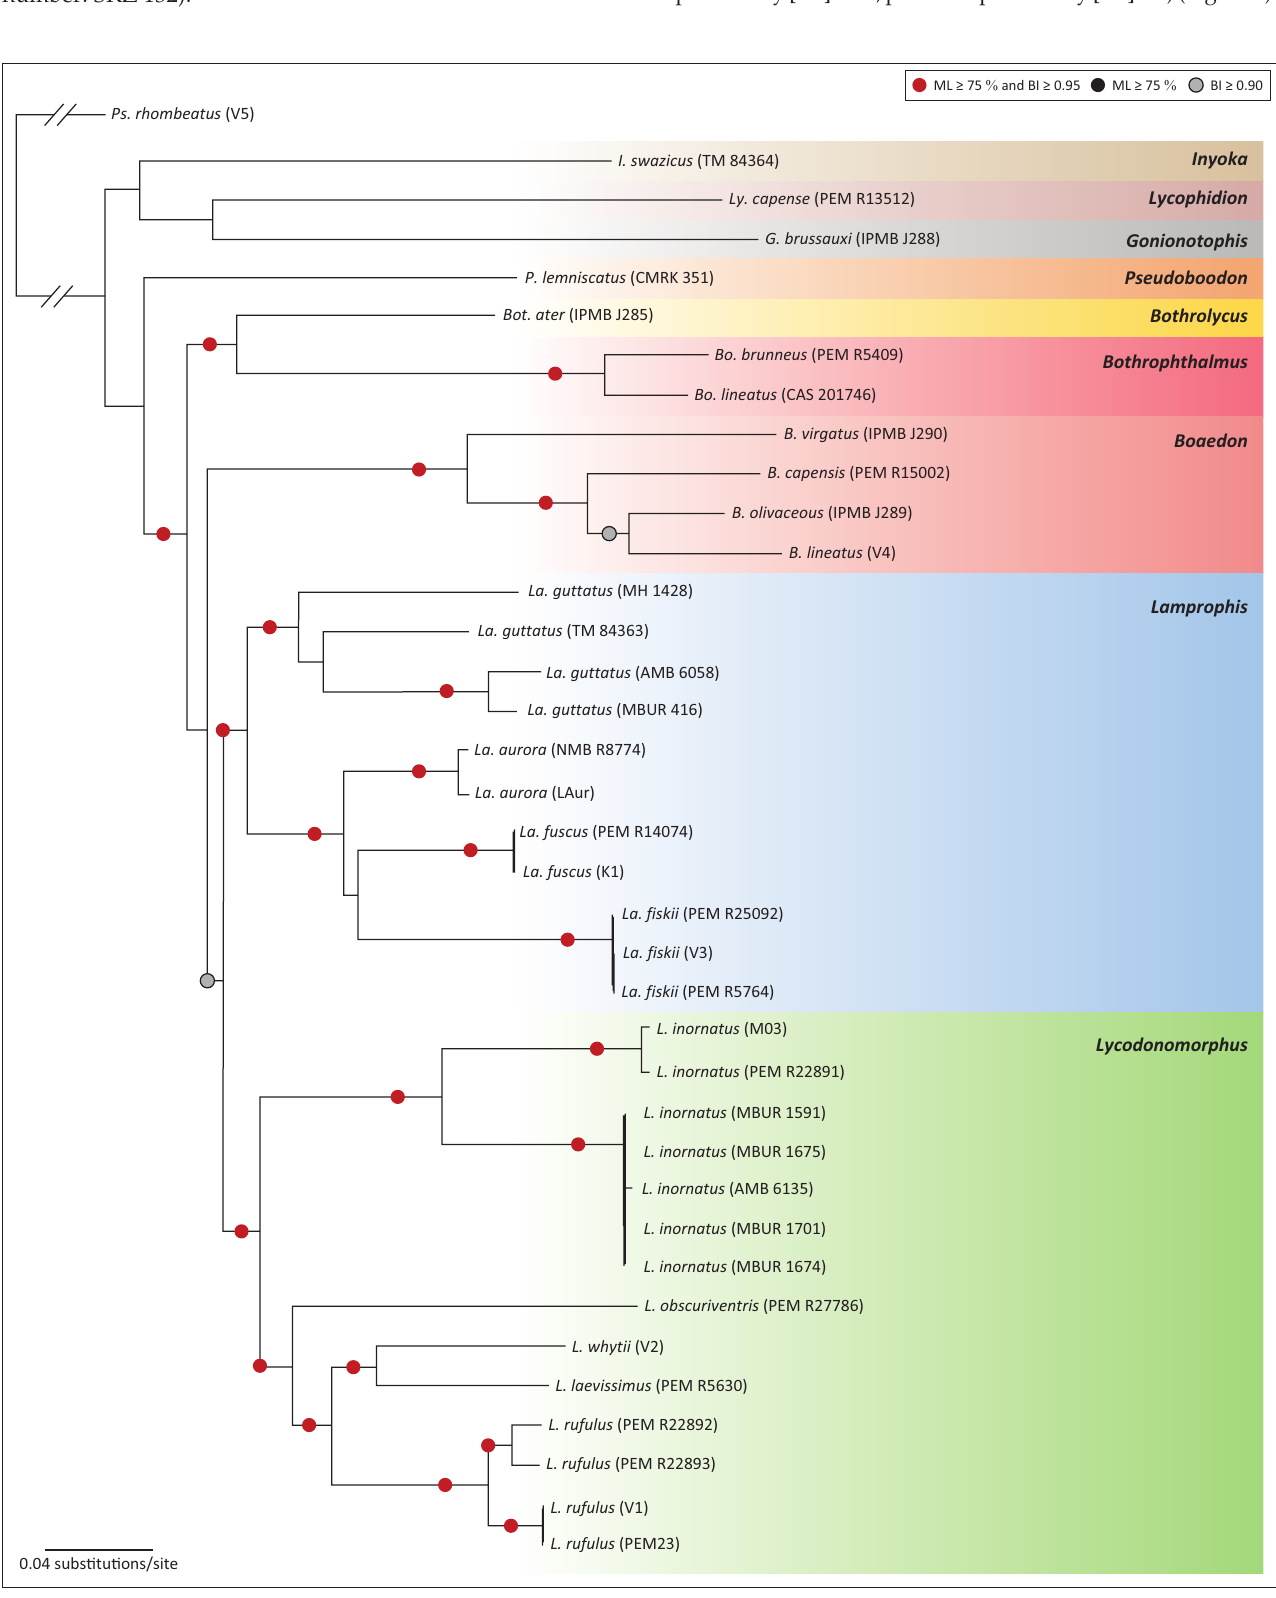
FIGURE 2: Maximum likelihood phylogenetic reconstruction with Bayesian inference support